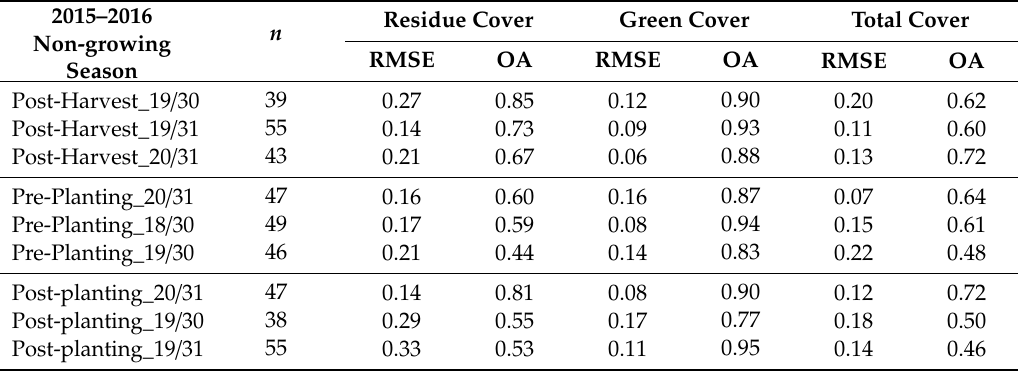
Table 8. Individual image accuracy results for linear regression (point fractions) and confusion matrix (fraction classes) for unmixing residue and green cover fractions (using corn residue + green cover + bare soil endmembers) and calculated total cover compared to in situ measures,